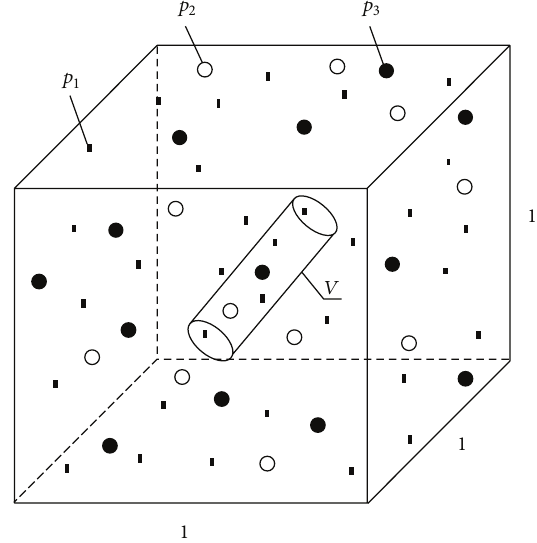
Figure 6: Three groups of defects characterized by individual probabilities 𝑝 1 = 0.2 , 𝑝 2 = 0.3 , and 𝑝 3 = 0.4 of fatigue crack initiation used in the Monte Carlo simulations. The region with volume 𝑉 is characterized by a fatigue stress range Δ𝜎